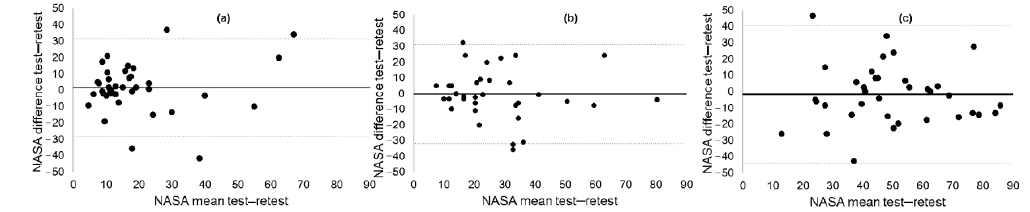
Figure 1. Bland–Altman plots of ( a ) 0-back NASA-TLX; ( b ) 1-back NASA-TLX; and ( c ) 2-back NASA-TLX.